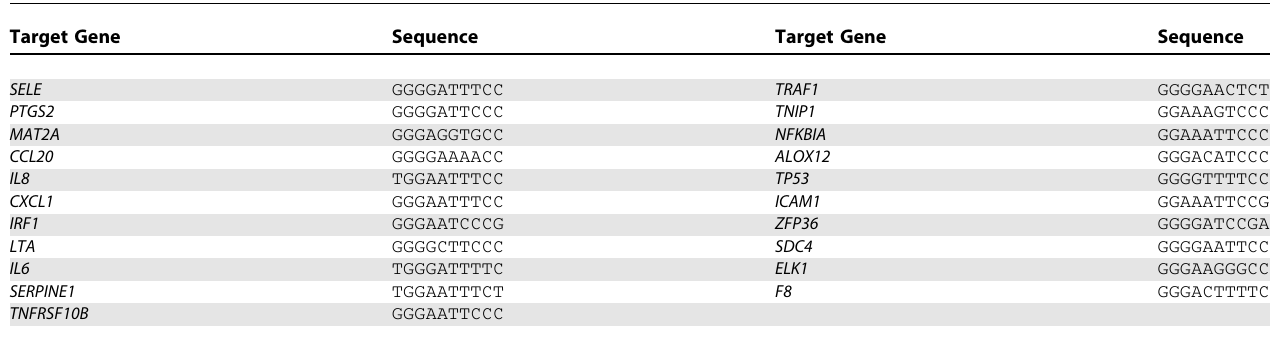
Table 3. Validated Human NF j B TFBSs Target